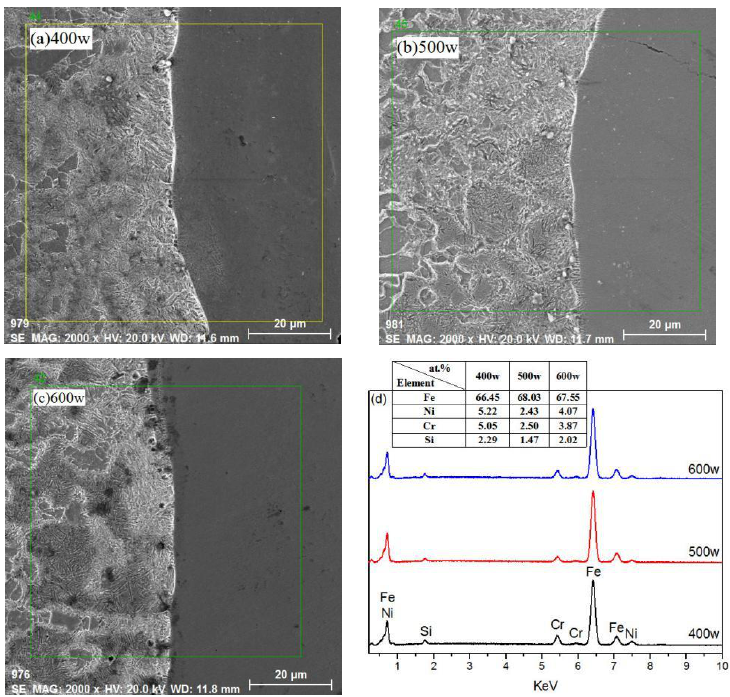
Figure 4. Scans taken after application of ( a ) 400 W, ( b ) 500 W, and ( c ) 600 W; ( d ) scan results to the